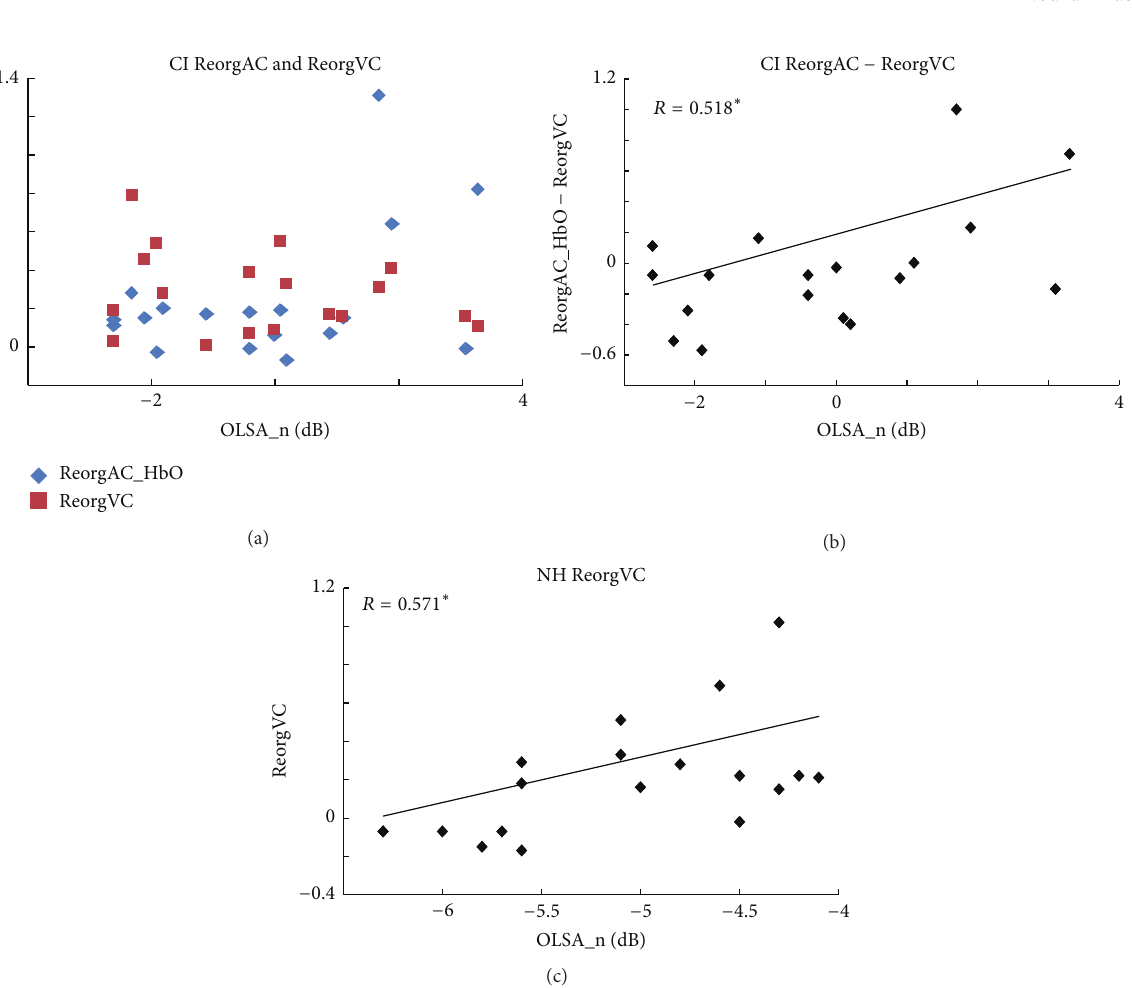
Figure 4: Correlations between the cross-modal reorganizations and the speech performance. (a) ReorgAC HbO and ReorgVC plotted separately for each CI user according to their speech performance. (b) Correlation between the difference of ReorgAC HbO and the ReorgVC and the test score for OLSA speech in noise (OLSA n). Note that the lower signal to noise ratio threshold for OLSA n test represents a better performance. (c) Correlation performed with NH controls. The 𝑦 -axis is the ReorgVC and the 𝑥 -axis is the OLSA n test score.